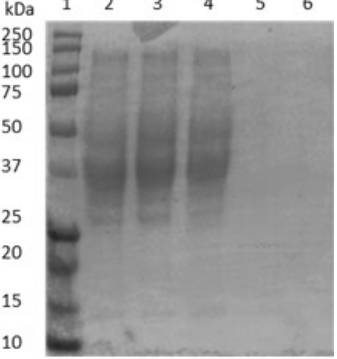
Figure 4. SDS-PAGE: Lane 1: low-molecular-weight standard (Precision Plus Protein, Bio-Rad); Lanes 2 and 3: supernatant at 24 h of immobilization in BGA and OGA, respectively; Lane 4: control sample (supernatant of BGA at t = 0 of immobilization); Lanes 5 and 6: catalyst immobilized in BGA and OGA, respectively .